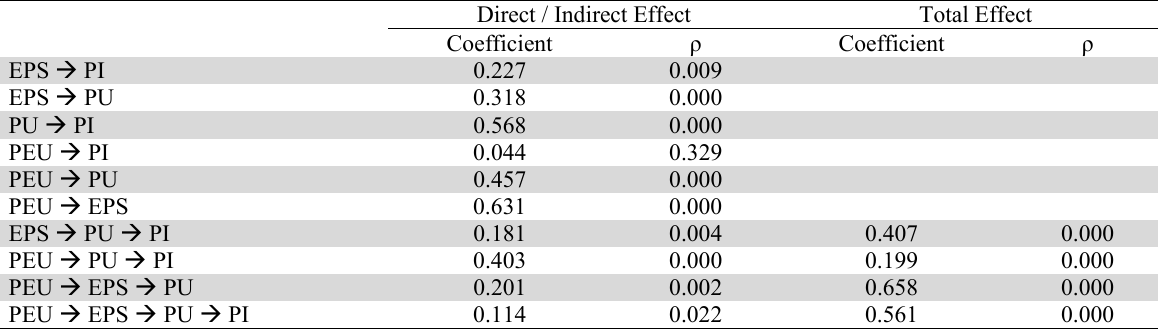
Direct, Indirect and Total